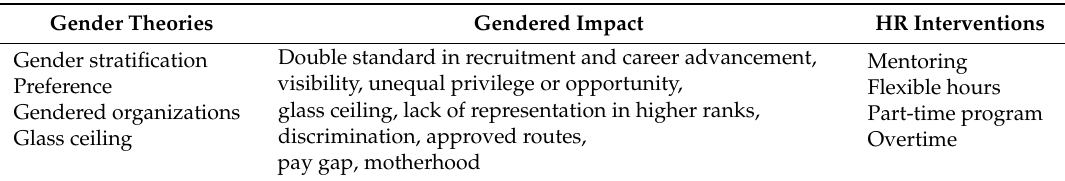
Table 2. Current research on gender in